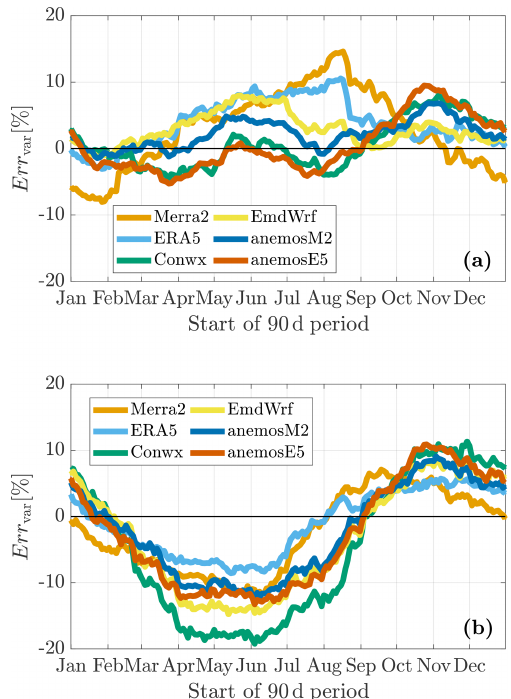
Figure 8. Temporal variations during the year of the bias in vari- ance Err var using the (a) variance ratio and (b) linear regression with residuals